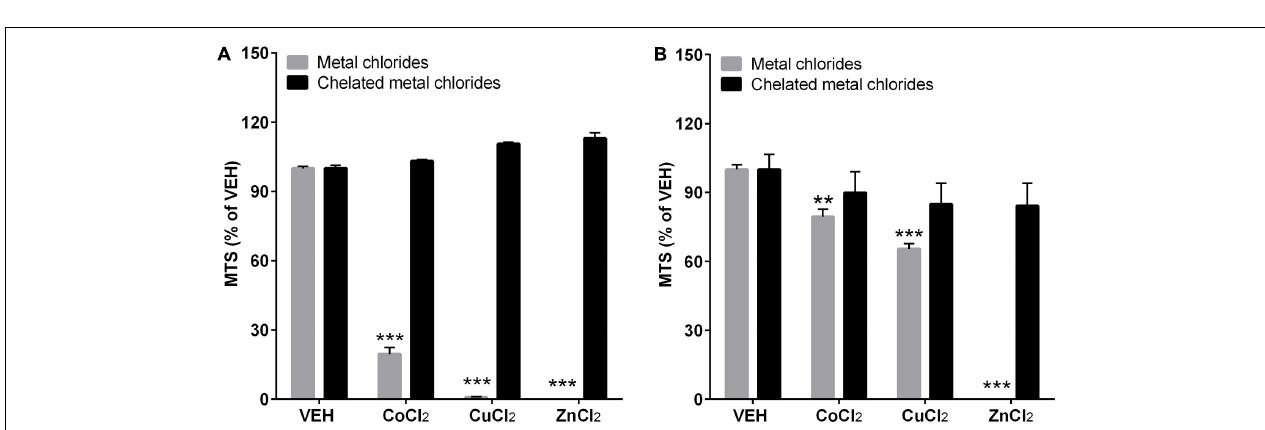
FIGURE 6 | The cytotoxicity assay after chelation of metal chlorides. The differentiated THP-1 cells (A) and A549 cells (B) were treated with or without chelation of metal ions. To chelated metal ions, Chelex 100 beads (Sigma–Aldrich) were applied to the stock solution of metal chlorides in DW and diluted to the final working concentration in cell culture media. The treated dose for both metal chlorides and chelated metal chlorides was 100 µ g/mL. Cytotoxicity was measured by MTS assay. Values are mean ± SEM from eight independent experiments. ∗∗ p < 0.01, and ∗∗∗ p < 0.001 vs. VEH.